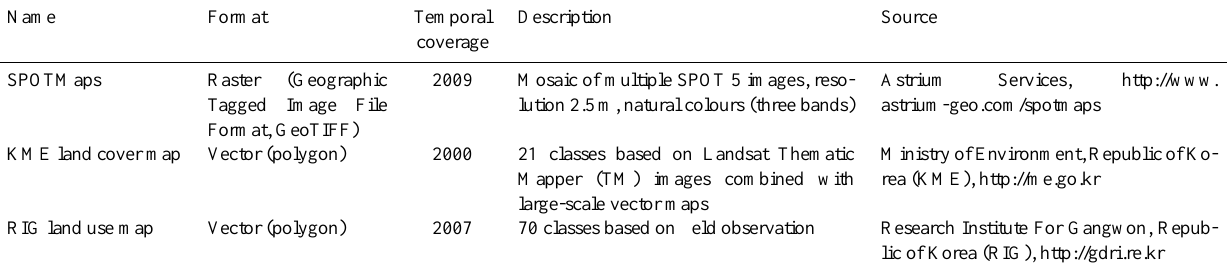
Table 1. Data used for the base map and gap filling. SPOTMaps served as the main background information for data collection. Maps by the Korean Ministry of Environment (KME) and by the Research Institute For Gangwon (RIG) provided previously recorded land use information and were also used for gap